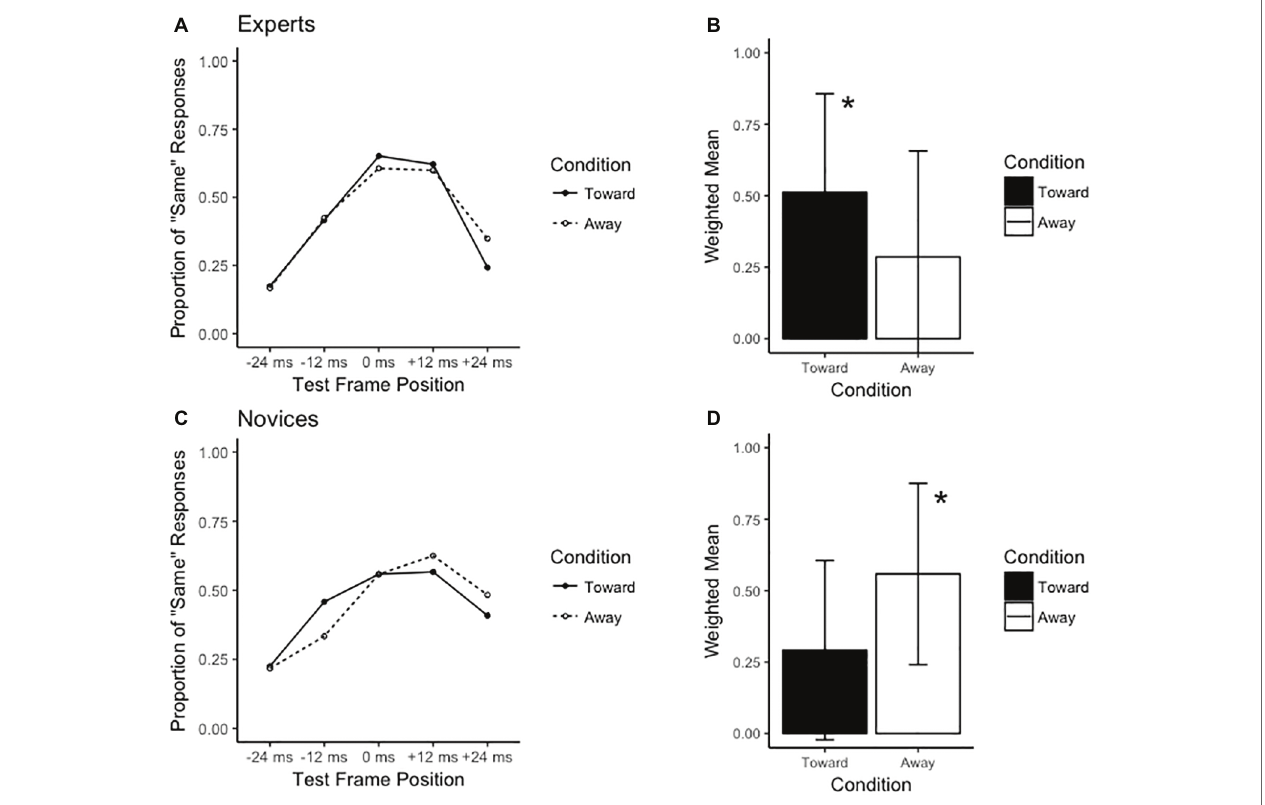
FIGURE 3 | Results for the leftward direction. The left-hand side of the figure displays the distribution of the proportion of “same” responses across test frame positions for (A) experts and (C) novices. The right-hand side displays the weighted means for (B) experts and (D) novices. * indicates significant difference from “away” condition at p <